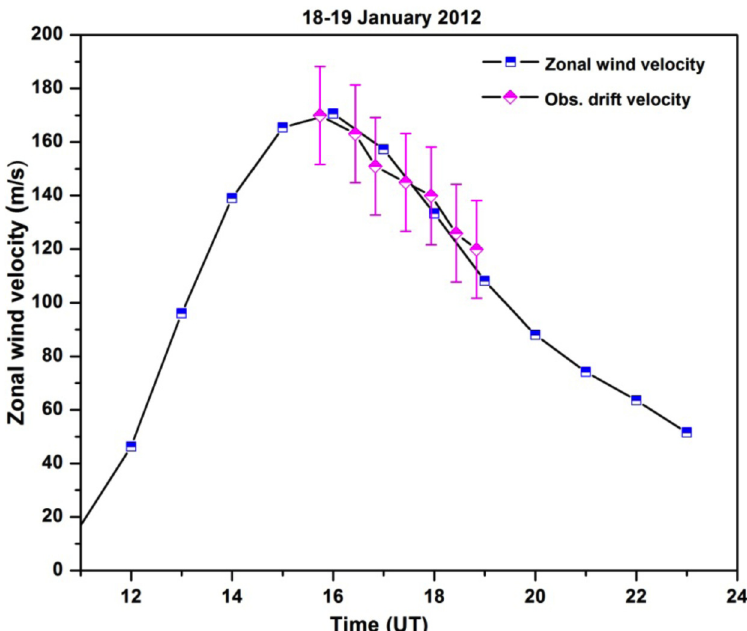
Figure 12. Comparison of observed EPB velocity with the zonal component of neutral wind velocity estimates by HWM07 on 18-19 Janu- ary 2012 at Kolhapur (half filled pink diamond). Error bar show the standard deviation in each